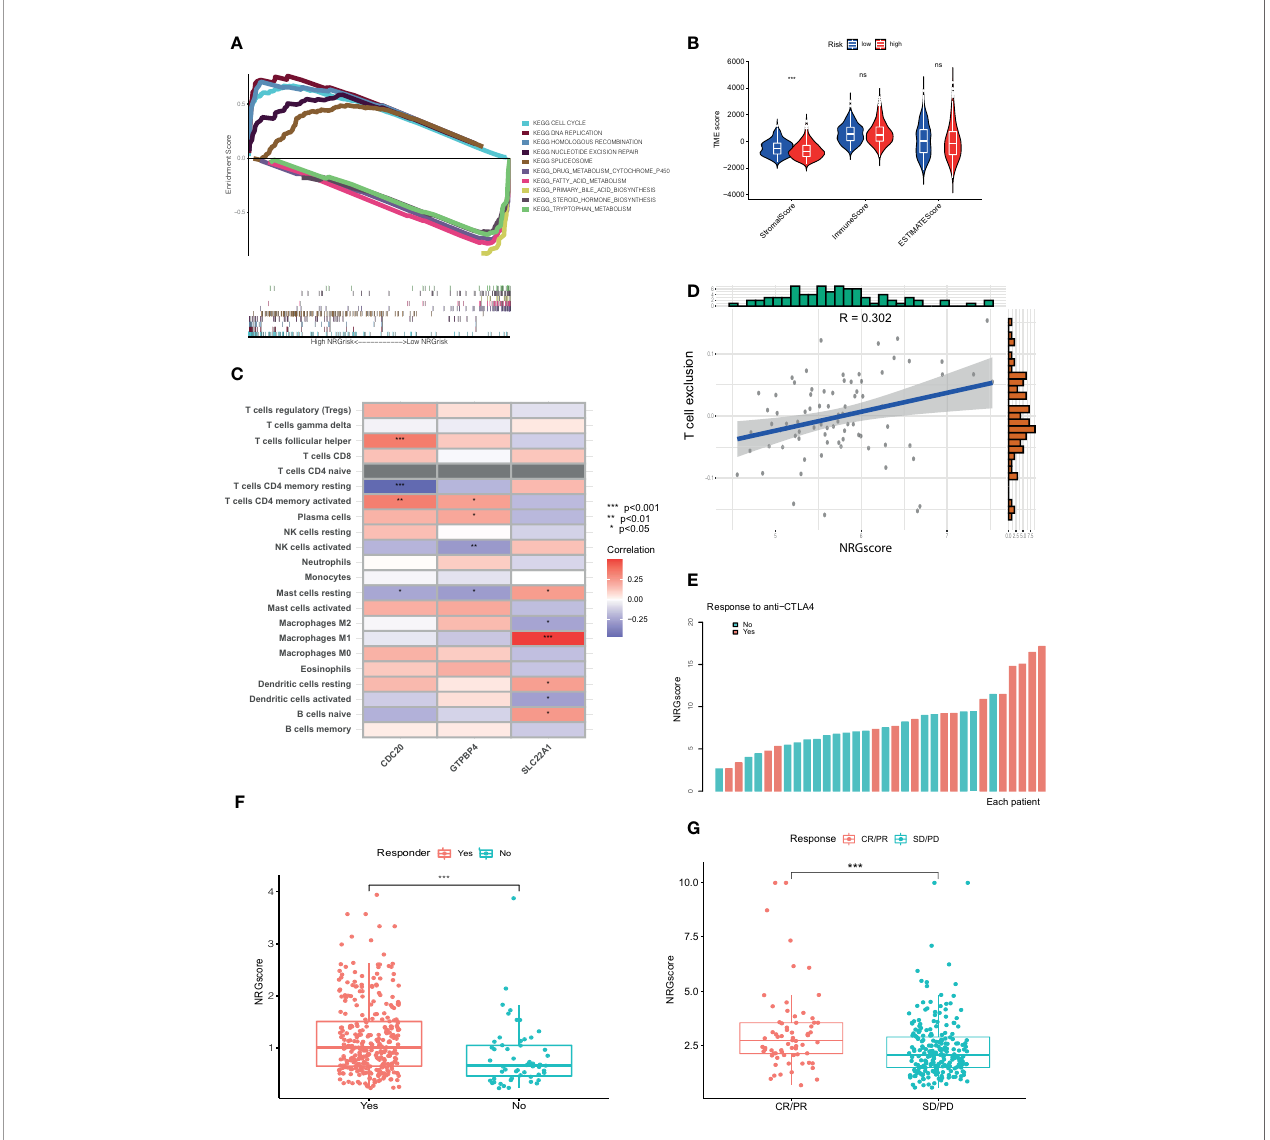
FIGURE 6 | NRGscore could accurately predict response to ICBs. (A) Different biological features in high and low NRGrisk groups by GSEA in KEGG pathways. (B) Violin diagrams exhibited the correlation of immune, stromal, and ESTIMATE scores with NRGrisk groups. (C) Heatmap indicated the relevance of TICs and three hub genes in NRGscore. Different colors represented the different degrees of correlation. (D) T cell exclusion score was positively associated with NRGscore in the GSE54236 HCC cohort. (E) Waterfall diagram of NRGscore with responder or non-responder to CTLA-4 cohort. (F) Patients who respond to ICB possess more NRGscore than non-responders in the TCGA cohort by the TIDE algorithm. (G) NRGscore of patients varied with different responses to immunotherapy in the advanced urothelial cancer cohort. CR/PR is short for complete response or partial response; SD/PD represented the stable disease or progressive disease. P<0.05 *; P<0.01**; P<0.001***. ICBs, immune checkpoint blockades; NRGscore, necroptosis-related gene score; TICs, tumor-in fi ltrating cells; NRGrisk, necroptosis-related gene risk; TIDE, tumor immune dysfunction, and